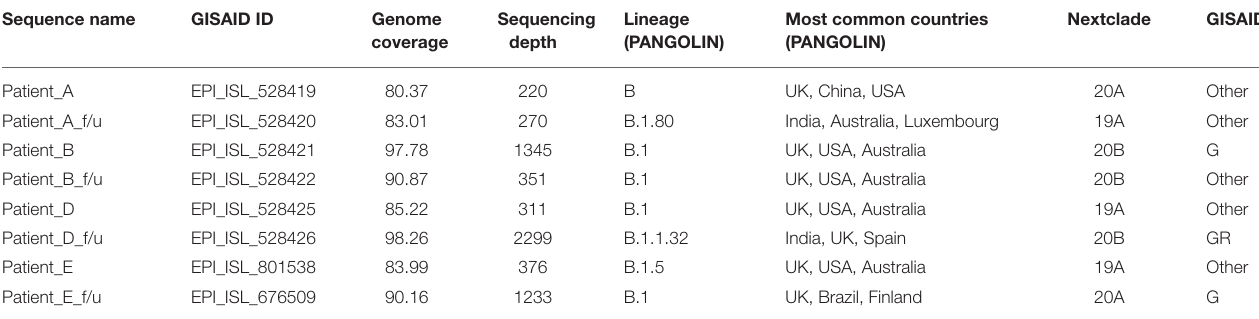
TABLE 2 | Clade, lineage of patients with reinfections ( n =